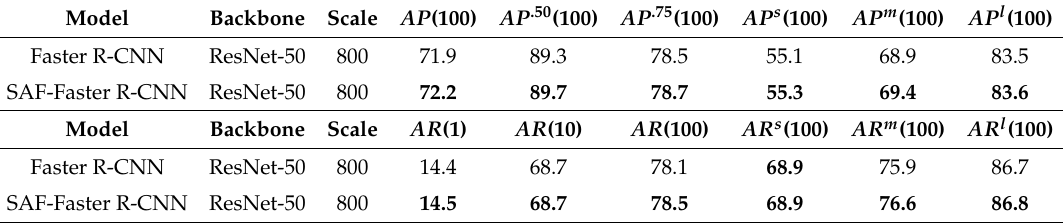
Table 5. Obstacle detection comparisons on the nuScenes test dataset [37] using the Faster R-CNN framework [6]. The top sub-table is about average precision metrics. In addition, the bottom sub-table is about average recall